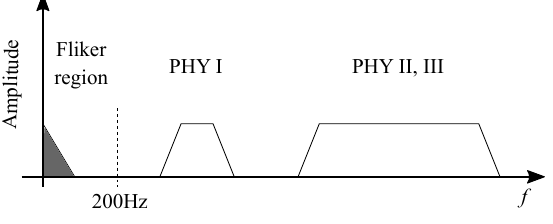
Figure 3. Physical layer frequencies; the gray band represents the ambient light